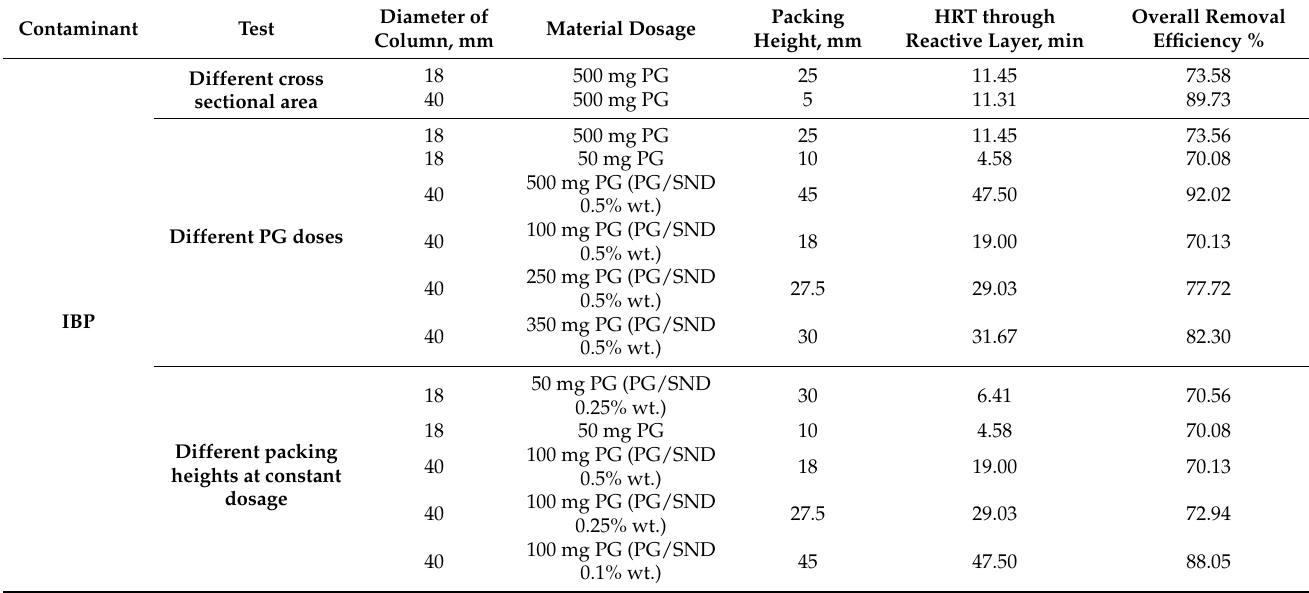
Table 4. Hydraulic retention time and overall removal efficiency of DCF removal by column filters of different cross sectional areas, PG doses, and packing heights at constant dosage. Experimental conditions: ECs-contaminated DW influent adjusted at 10.5 mg/L of EC; room temperature at 22 ± 3 ◦ C.